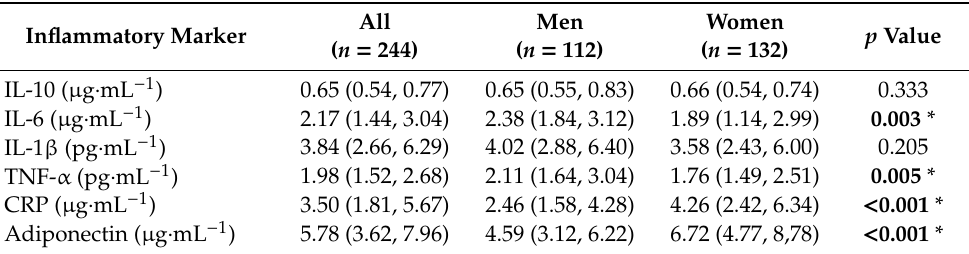
Table 3. Cytokine concentrations of participants in the study.